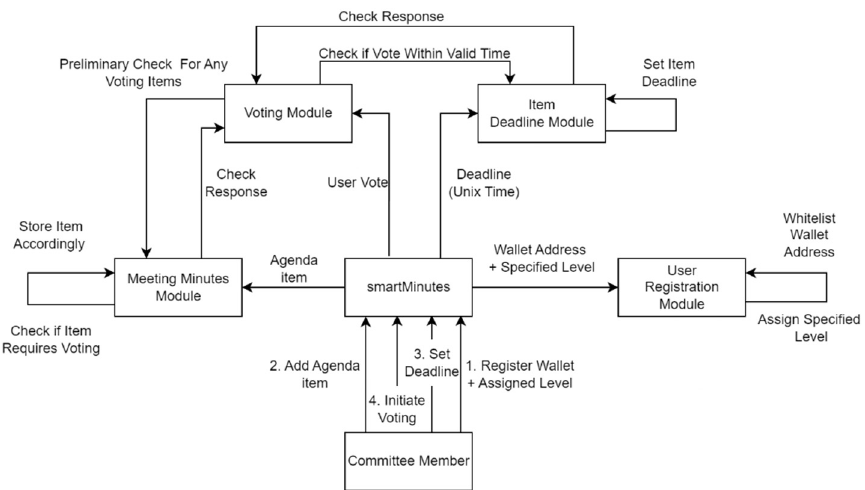
Figure 3. smartMinutes operations diagram.